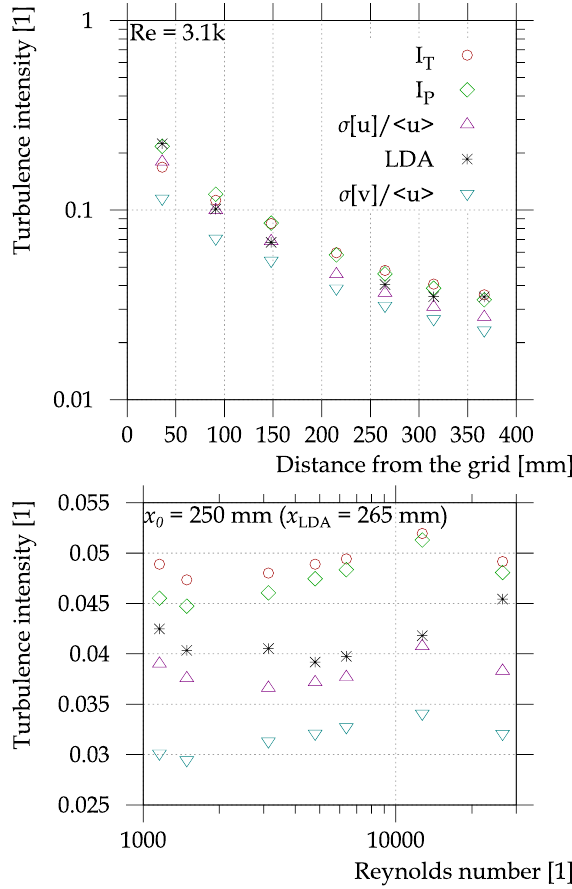
Fig. 6. Top : intensity of turbulence obtained by using di ff erent approaches as a function of distance from the grid. The Reynolds number is 3 . 1 · 10 3 . Bottom : intensities of turbulence as a func- tion of Reynolds number at constant mean distance from the grid x 0 = 250mm = 16 M , x center = 265mm = 17 M . I T and I P re- flects the temporal and spatial intensity calculated according to equations (3) and (4) respectively, The data obtained from LDA, which measures x -component only, can be compared only with the stream-wise turbulence intensity σ [ u ] / ⟨ u ⟩ . For complexity, there is also plotted the span-wise component σ [ v ] / ⟨ u ⟩ , which is normalized by stream-wise velocity, as the mean value of span- wise velocity is close to